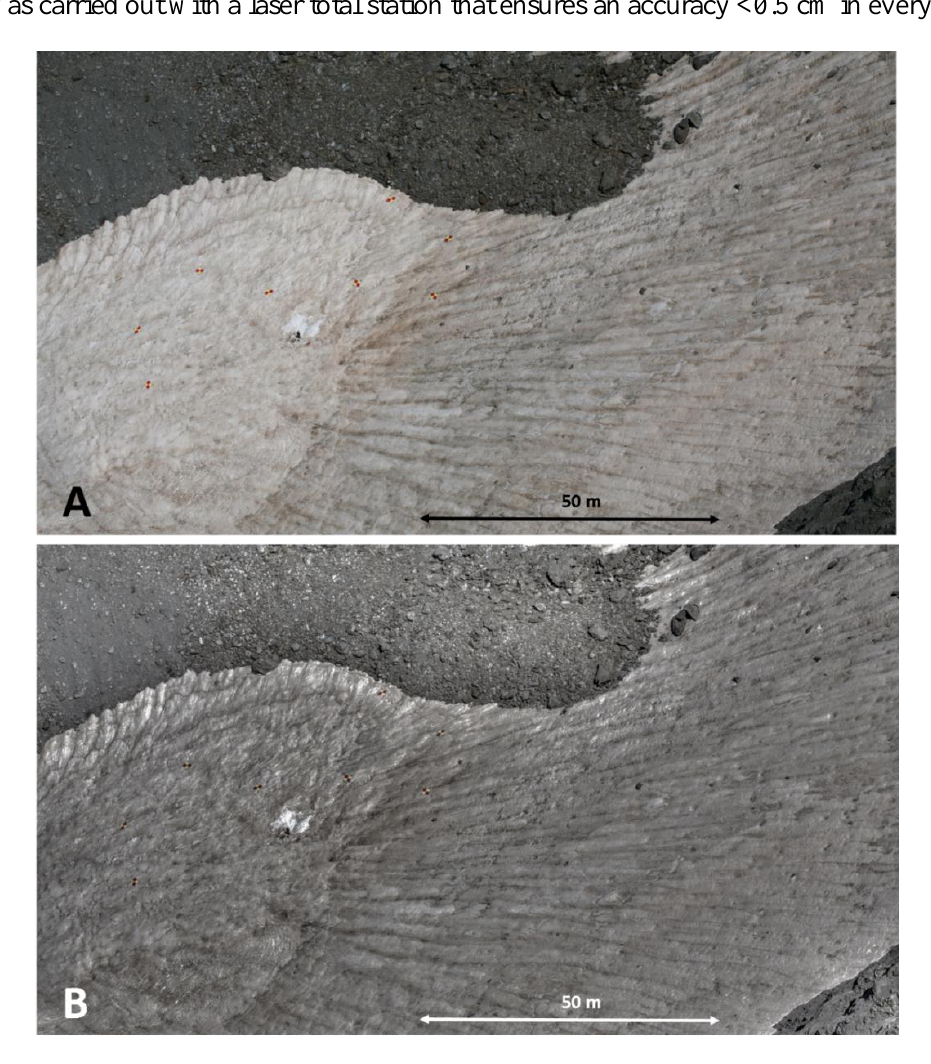
Figure 5. ( A ) Oblique Low Dynamic Range conventional image (LDR) and ( B ) oblique High Dynamic Range composition (HDR, i.e. , elaborated with three conventional photographs acquired with Exposition Values of −1.00, 0.00 and +1.00) of the Corral del Veleta rock glacier in 2011. Control points can be observed in red and yellow color for both images. Note that these photographs are not orthorectified and referenced so only an approximate reference distance is shown in the